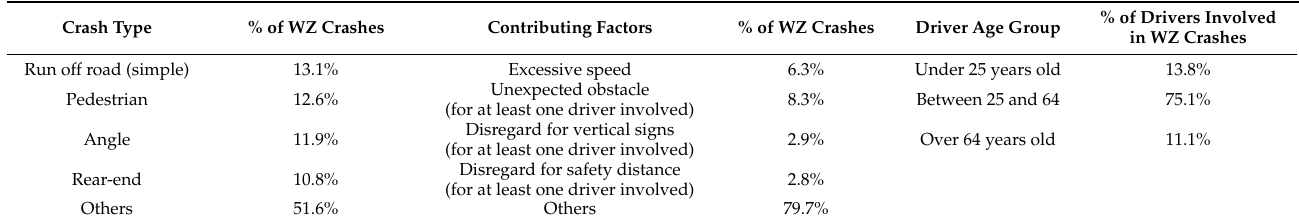
Table 2. Descriptive statistics of the dependent variables.